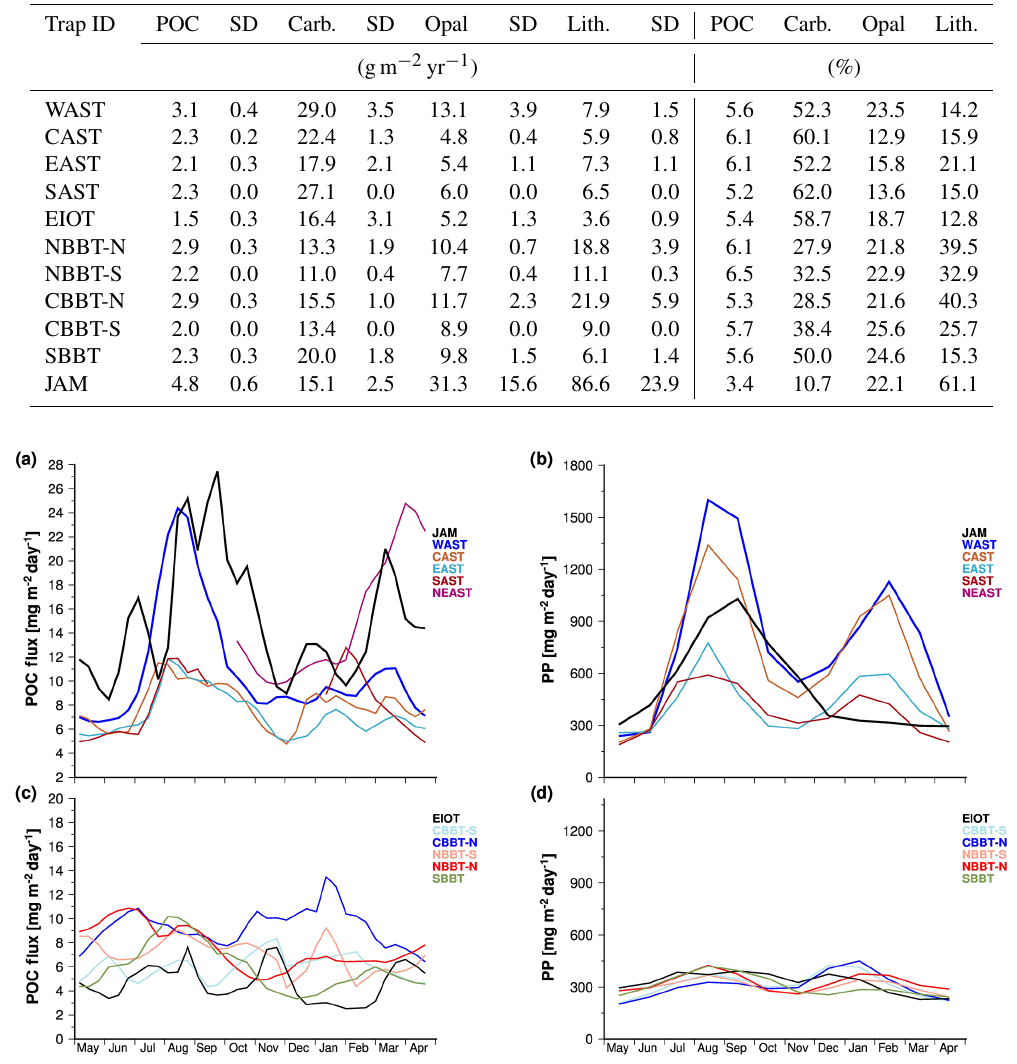
Figure 3. Monthly mean organic carbon fluxes (POC) obtained from our sediment trap experiments in the Arabian Sea (a) and the Bay of Bengal (c) as well as monthly mean primary production rates (Behrenfeld and Falkowski, 1997) selected for the sediment trap sites (b, d) . The sediment trap data were normalised to a water depth of 2000m by using the equation introduced by Rixen et al.